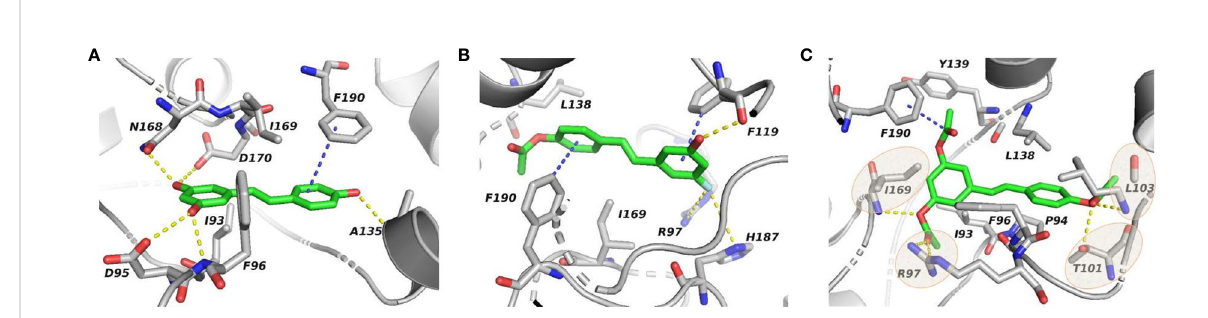
FIGURE 7 Ligand-binding pocket in SIRT2 for Resveratrol (A) , Resveratrol analog 2 (B) , and Resveratrol analog 10 (C) , respectively. Gray cartoon representations are used for the receptor. Sticks represent resveratrol and its analogs (green carbons) as well as receptor residues (grey carbons) involved in ligand binding.